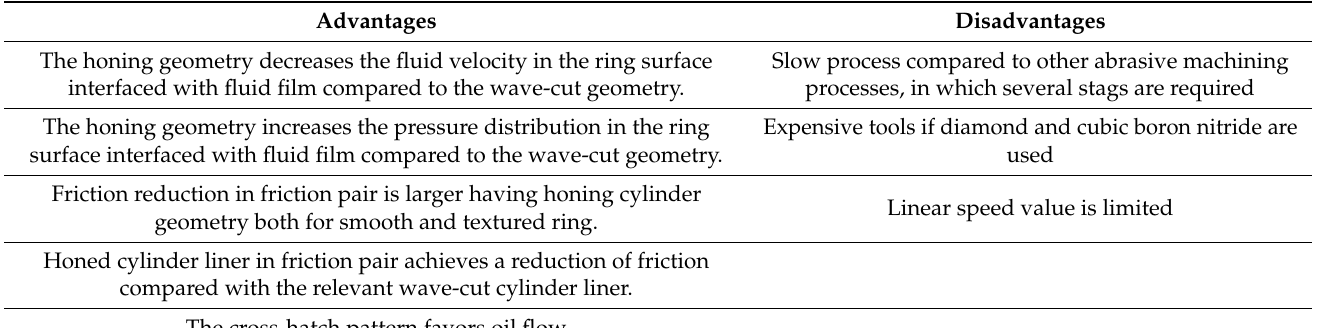
Table 1. Main advantages and disadvantages of the honing process [3,22,54,55]. Advantages Disadvantages The honing geometry decreases the fluid velocity in the ring surface Slow process compared to other abrasive machining interfaced with fluid film compared to the wave-cut geometry. processes, in which several stags are required The honing geometry increases the pressure distribution in the ring Expensive tools if diamond and cubic boron nitride are surface interfaced with fluid film compared to the wave-cut geometry. used Friction reduction in friction pair is larger having honing cylinder Linear speed value is limited geometry both for smooth and textured ring. Honed cylinder liner in friction pair achieves a reduction of friction compared with the relevant wave-cut cylinder